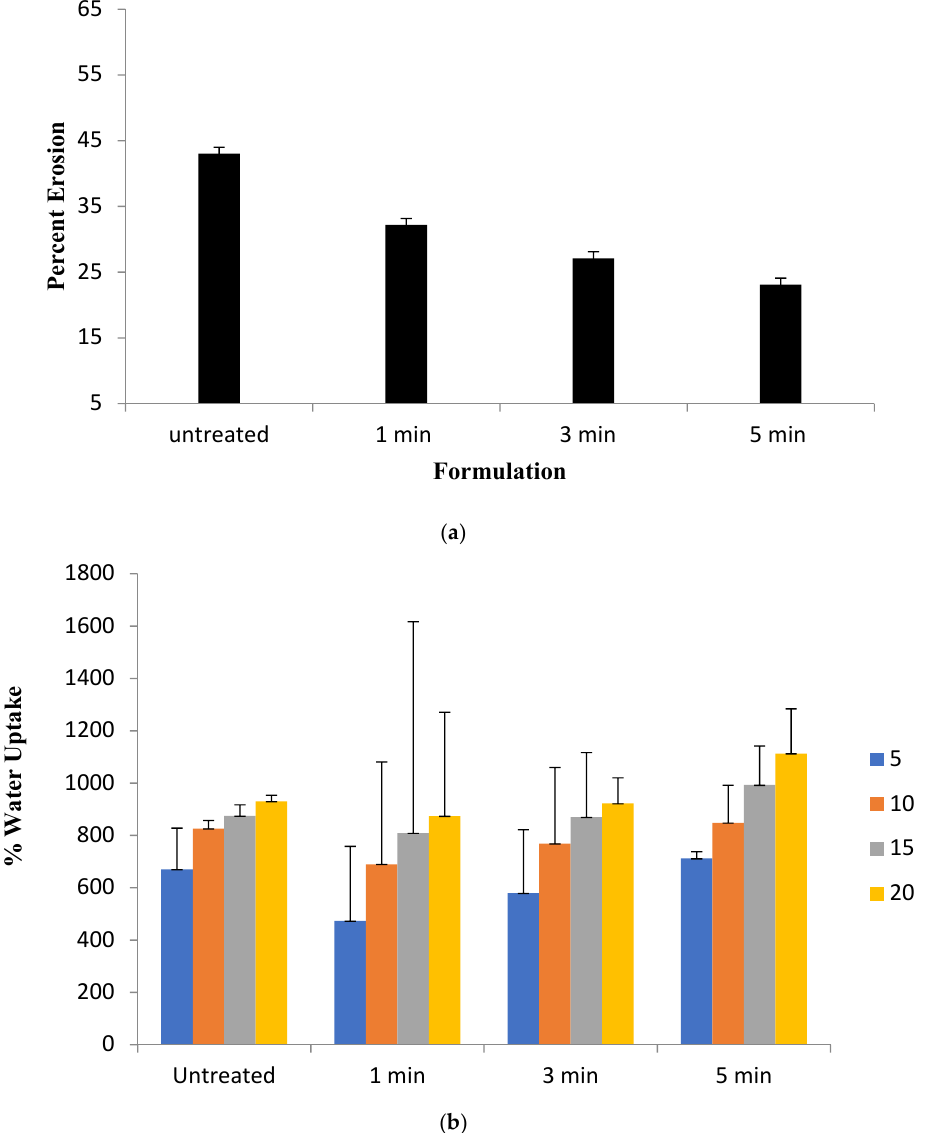
Figure 2. ( a ) Percent erosion; ( b ) water uptake of blend films.